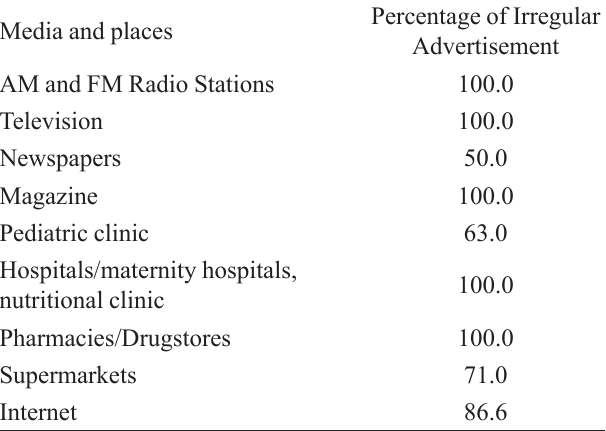
TABLE V - Percent of irregular advertisement of infant foods of diverse categories (A, C, D) concerning NBCAL, in different types of media and collection places Media and places